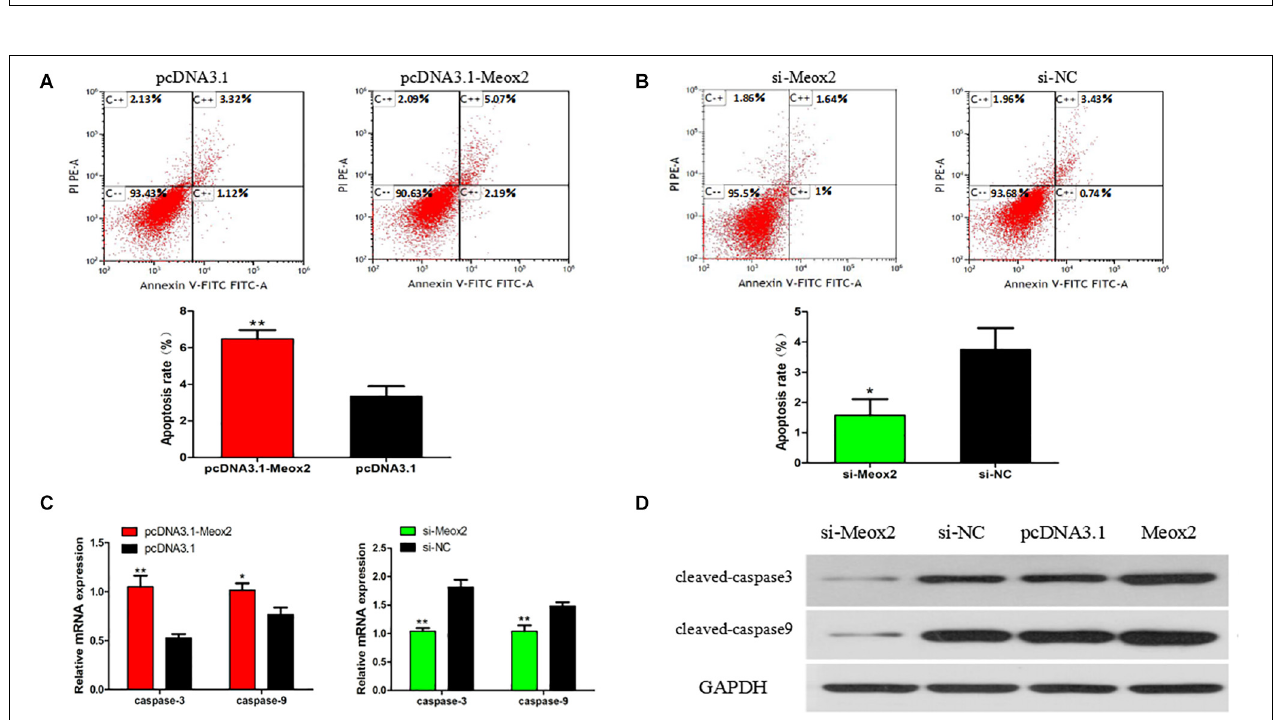
FIGURE 8 | Effect of Meox2 on rate of apoptosis in SMSCs. Scattergram and rate of apoptosis in SMSCs transfected with pCD3.1-Meox2 (A) or siRNA-Meox2 (B) as analyzed using flow cytometry following staining with annexin V and PI. (C,D) Abundance of mRNA and proteins of caspase 3 and caspase 9 in SMSCs transfected with pCD3.1-Meox2 as determined by use of Western blot analysis. Data are expressed as mean ± SEM ( N = 3). * P < 0.05; ** P < 0.01 vs.